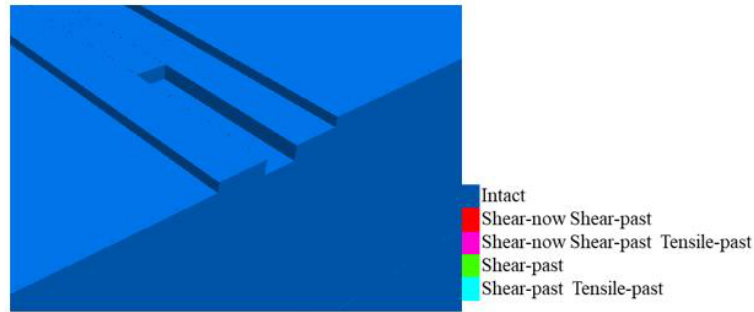
Figure 14. The yield state of the foundation rock mass.